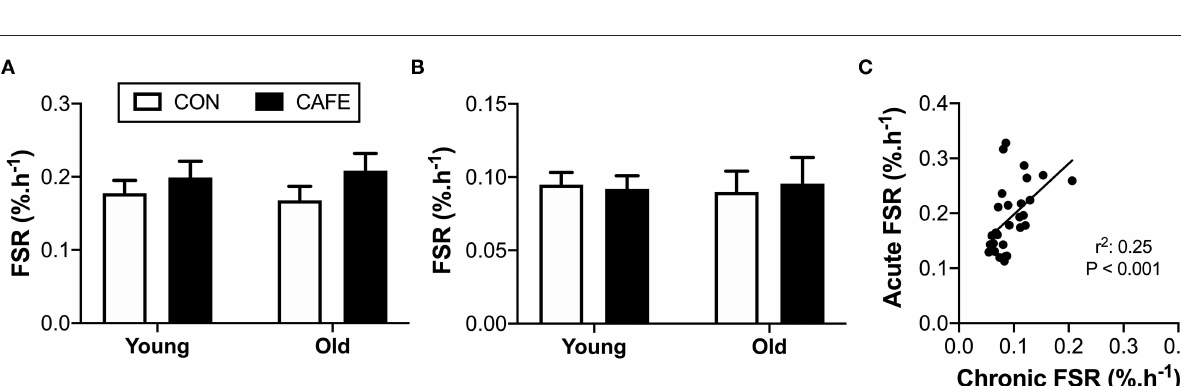
FIGURE 3 | Uncoupled mitochondrial respiration rates of brown adipose tissue in Brown Norway rats subjected to a 12-week cafeteria diet. Main bars represent total uncoupled respiration normalized to tissue weight. Shaded and non-shaded areas of each bar represent the contribution of UCP1-dependent and UCP1-independent respiration to total uncoupled respiration, respectively. Values represent means ± SEM. Bars with differing letters denote significance ( P < 0.05). n = 6–7/group.